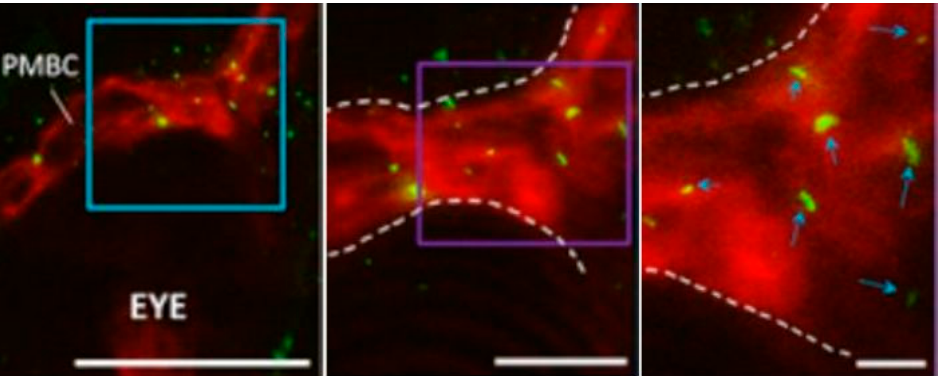
Figure 4. Determination of “cilia” distribution on EC membranes of primordial cerebral vessels. Confocal micrographs of GFP-labeled primordial midbrain channel in transgenic line Tg (kdrl:mCherry-CAAX) y171 and (bactin::Arll3b:GFP) to help label EC membranes. Scale bar = 40 µm [22].